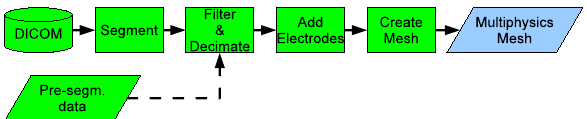
Fig. 9: Overview over the segmentation and meshing meshing process. The raw data is coming from a DICOM source such as MRI or CT. As an alternative, one may use pre-segmented data (dashed arrow). This is done using Scan IP+FE, and the output is a mesh usable by Multiphysics.